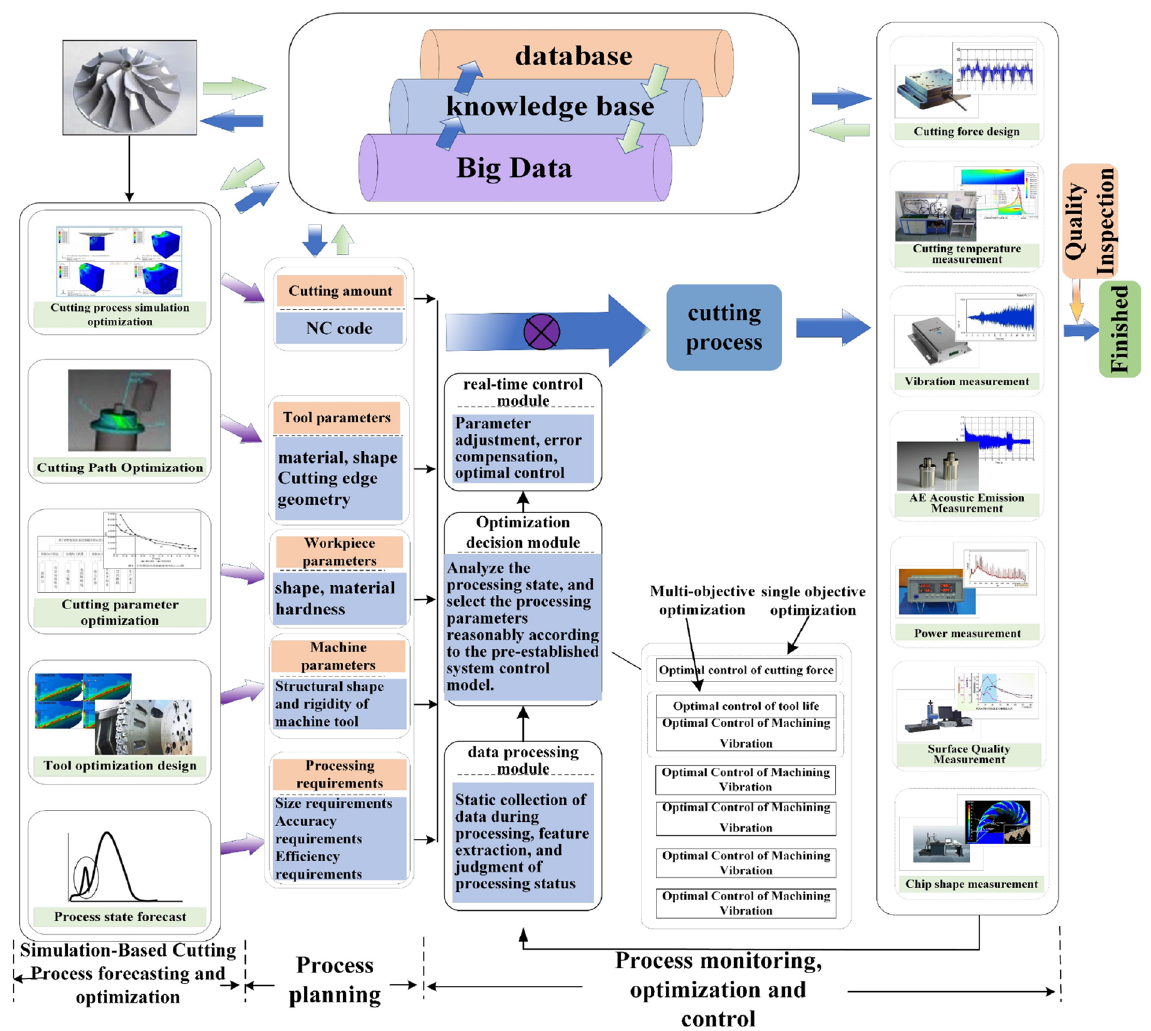
Fig. 2 Research framework of tool wear problem [28,